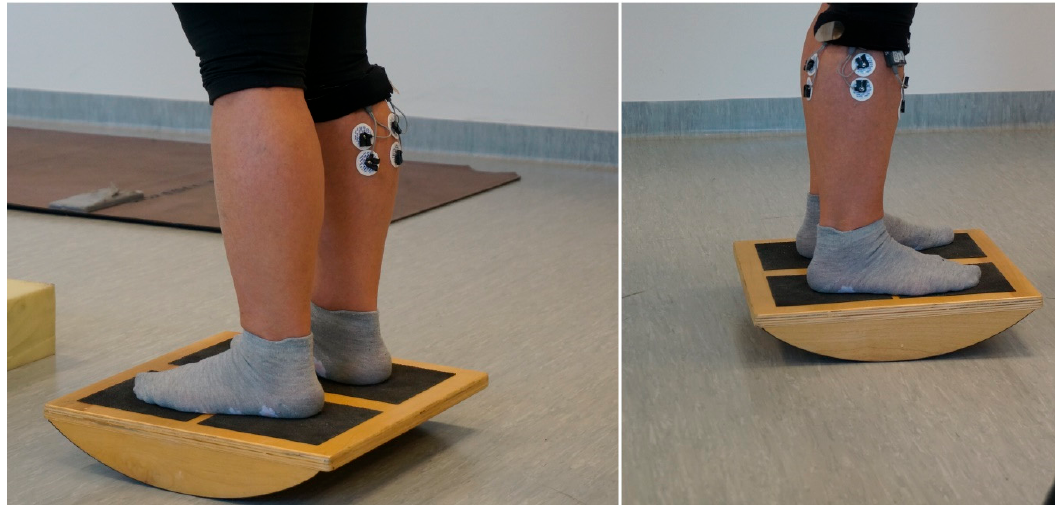
Figure 1. Illustration of EMG signal recording process.